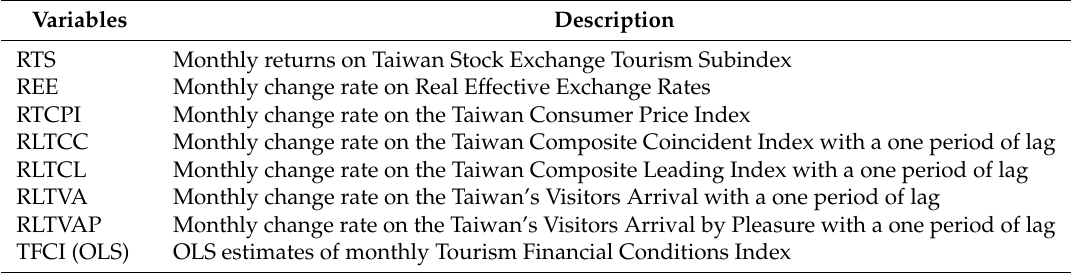
Table 1. Description of